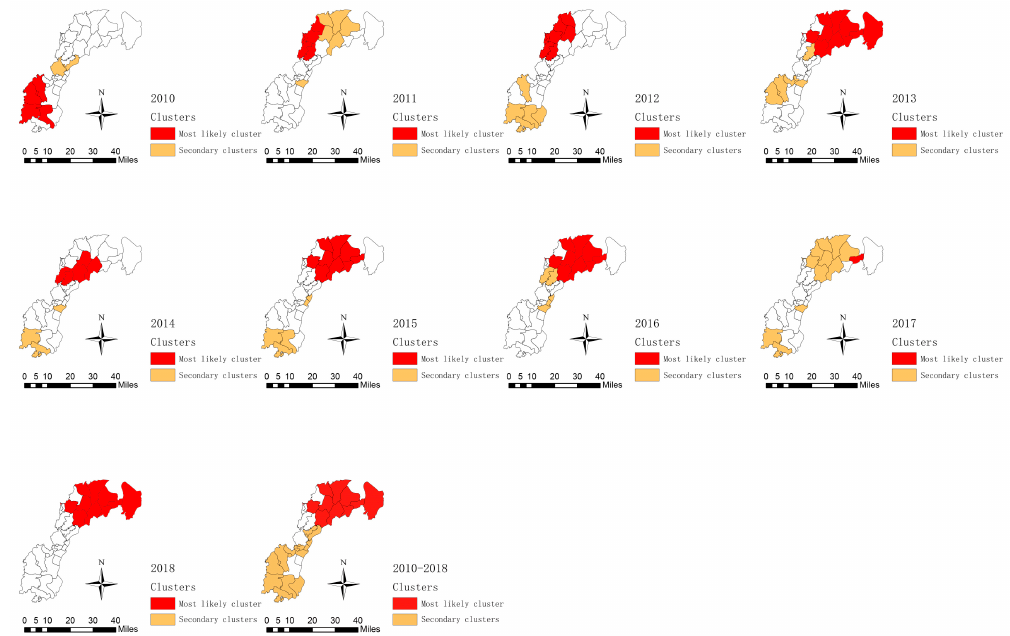
Figure 6. Yearly spatiotemporal clusters of tuberculosis cases in the new urban area of Nanchang from 2010 to 2018 using Kulldorff’s space–time scan statistic.